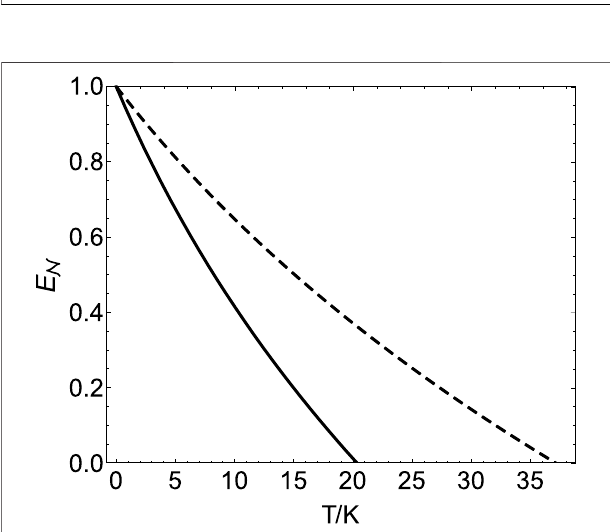
FIGURE9| Logarithmicnegativity E N asafunctionoftemperature ofthe system for different masses of oscillator. When ω c (cid:1) ω 0 , the mass of oscillator with 10 ng is for the solid line, and m = 100 ng is for the dash